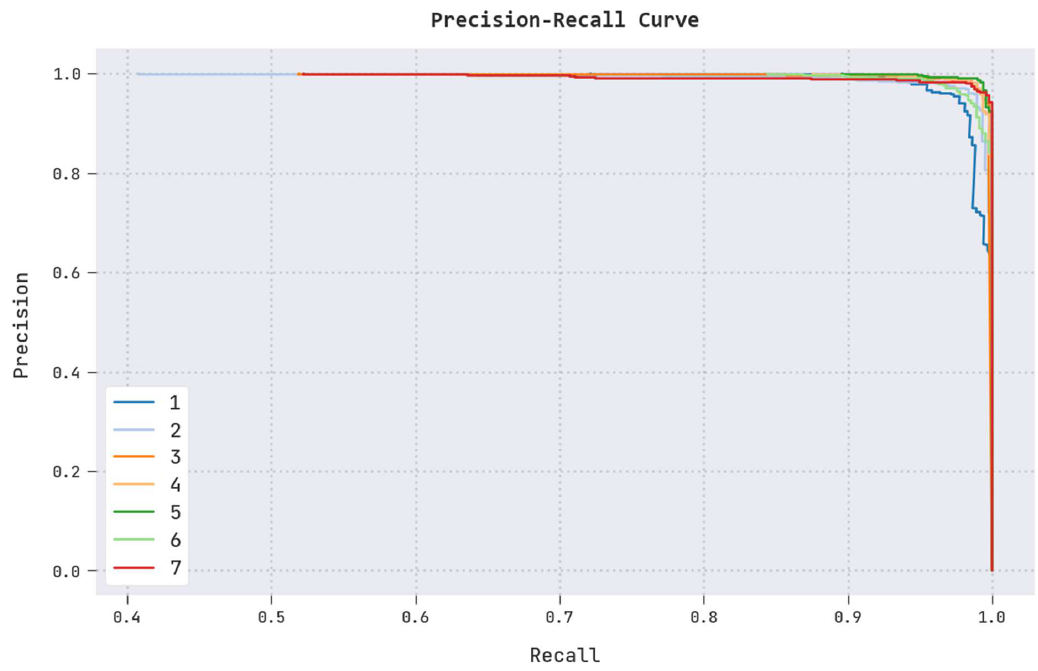
Figure 6. Precision-recall analysis of the CL-DLBIDC approach.